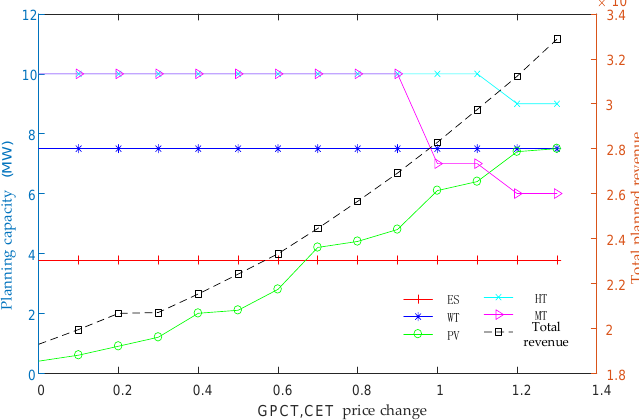
Figure 6. The impact of GPCT and CET price changes on planning.